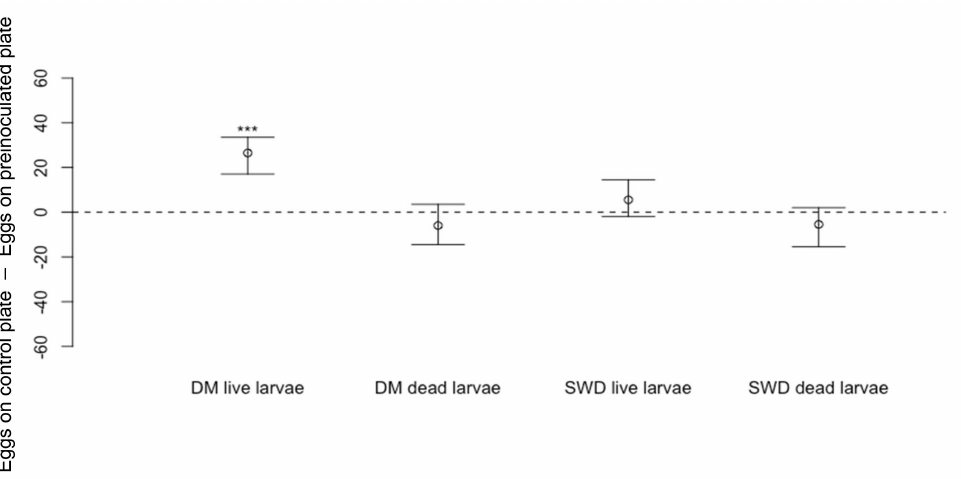
Figure 9. Differences in numbers of eggs laid by Drosophila suzukii (Median ± 95% confidence intervals) laid on cornmeal media dishes which contained live or dead larvae of D. melanogaster (DM: n = 18, p < 0.001 *** and n = 18, p = 0.28, respectively) or D. suzukii (SWD: n = 18, p = 0.13 and n = 18, p = 0.14, respectively) compared to numbers on blank cornmeal media dishes.